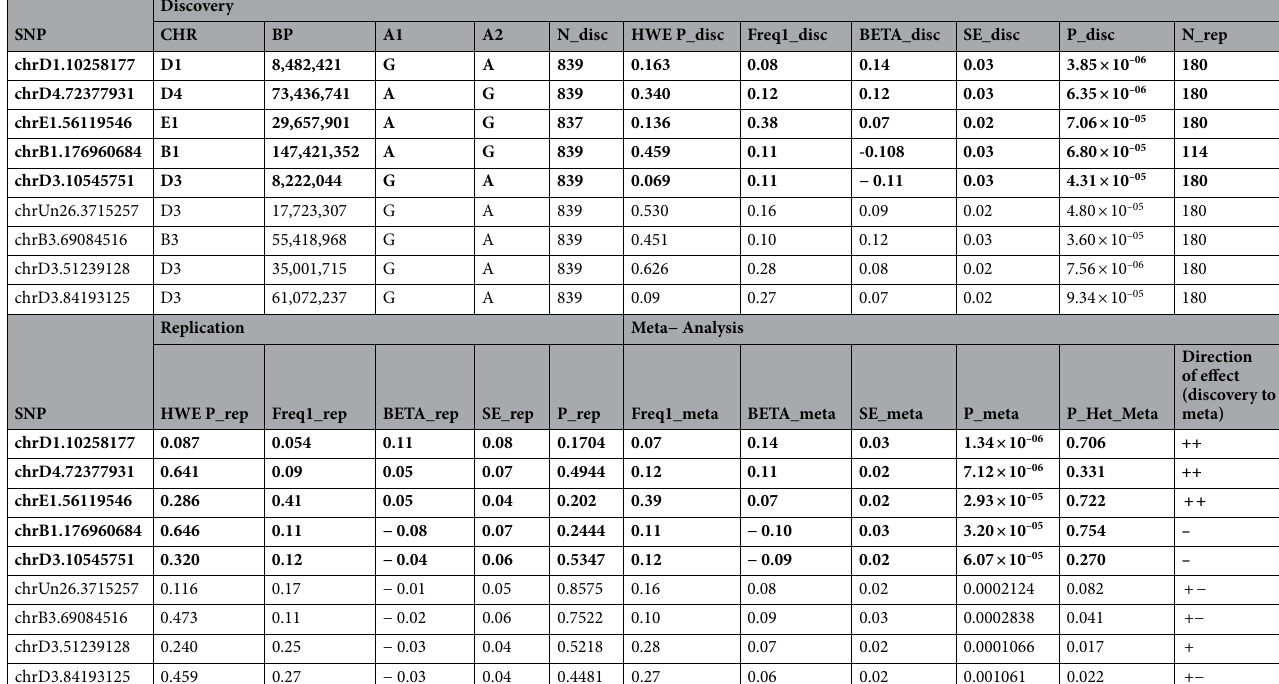
Table 3. Comparison of discovery, replication and meta-analysis for Log creatinine. SNP; single nucleotide polymorphism (Named from Illumina Feline Infinium Array), CHR; chromosome (FelCat5; Felis_catus- 6.2 Genome assembly), BP; base pairs (FelCat5; Felis_catus-6.2 Genome assembly), A1; minor allele, A2; major allele, N; number, HWE; Hardy Weinberg Equilibrium, freq1; frequency of minor allele, BETA; beta, SE; standard error, p; significance, _disc; discovery, _rep; replication, _meta; combined metanalysis. Data table ordered by meta-analysis significance. Bold indicates experimental wide significance for meta-analysis ( P < 1 × 10 –6 ) and/or concordance of direction of